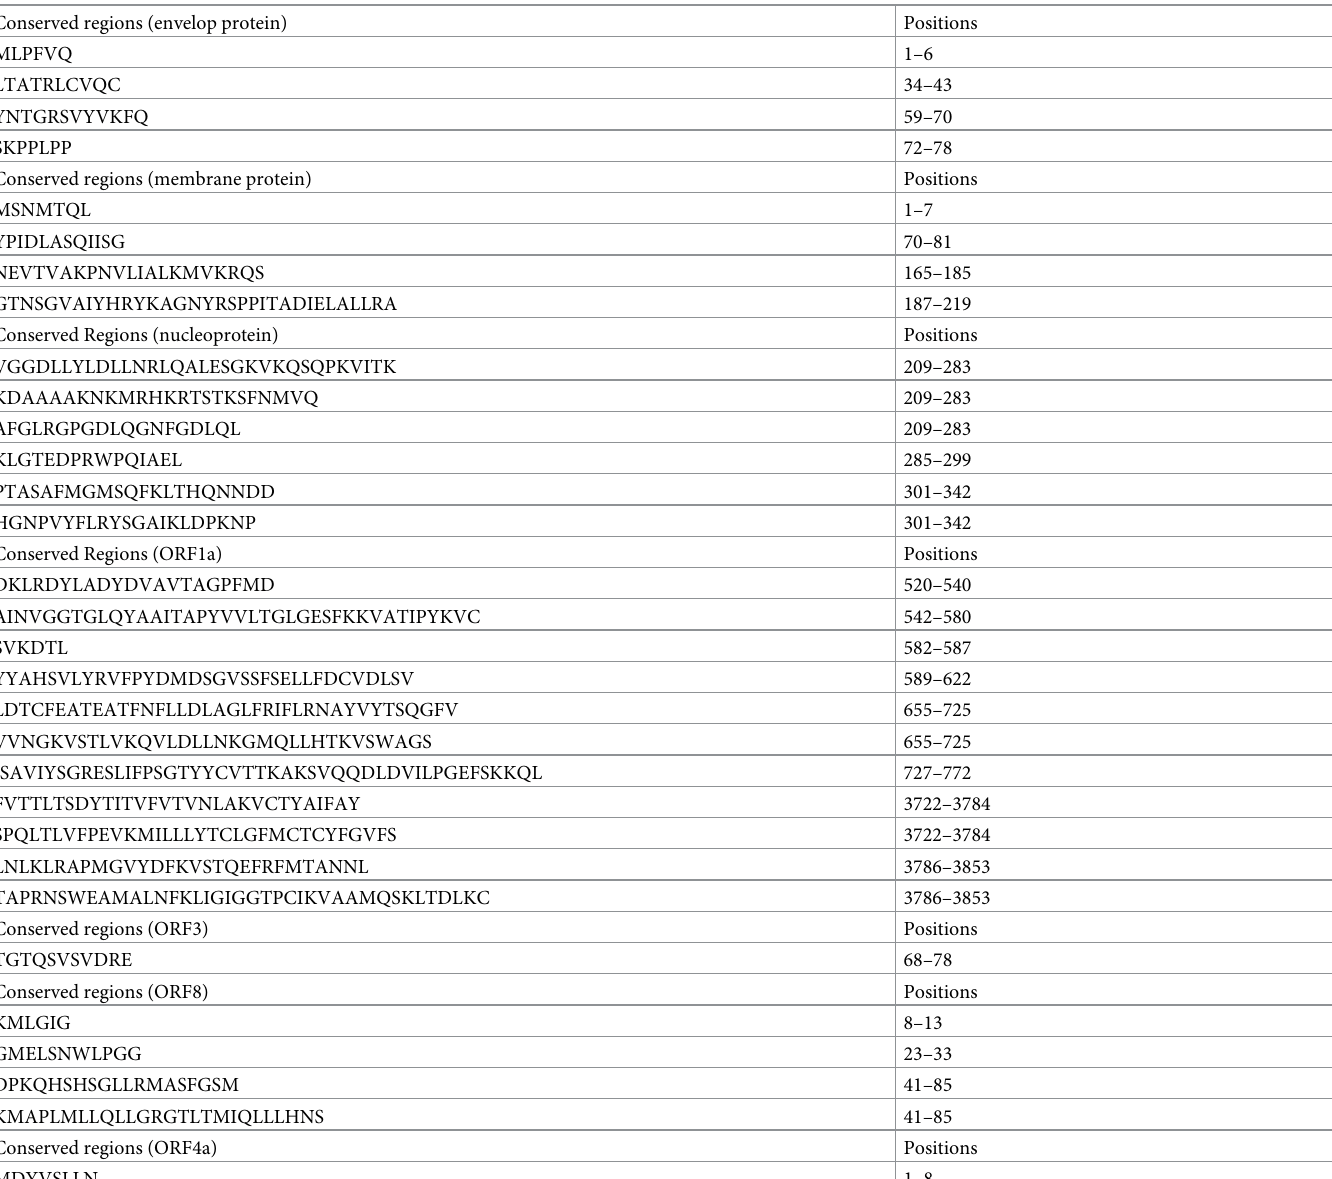
Table 1. Conserved regions in MERS-CoV (E), (M), (N), ORF1a/4a, ORF3/8. Conserved regions (envelop